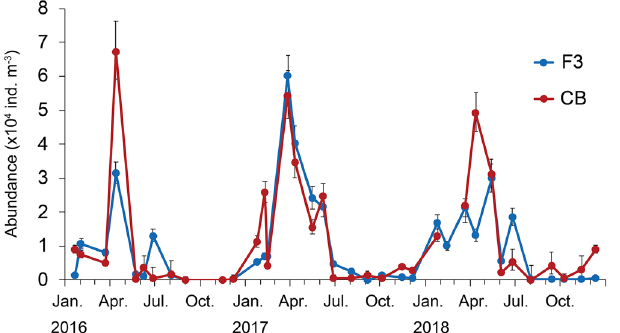
Figure 3. Seasonal changes in Acartia omorii abundance at St. F3 and St. CB from January 21, 2016 through June 26,